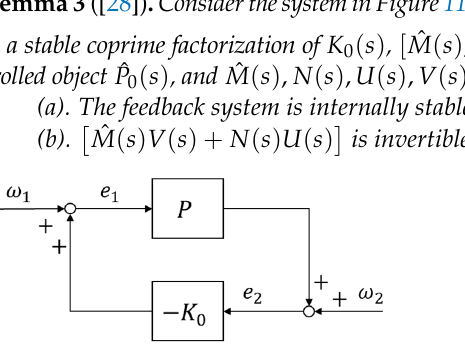
Figure 11. Block diagram of internal stability analysis.